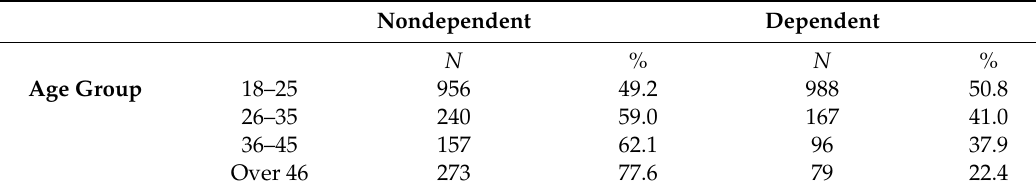
Table 4. Participant’s smartphone dependence according to the variable age group.